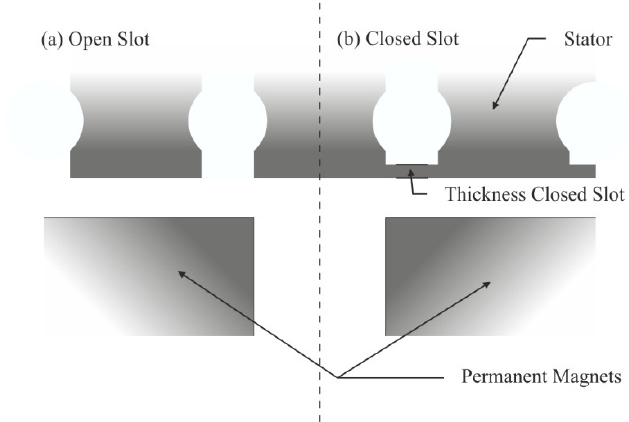
Figure 2. One section of the linear generator showing the difference between: ( a ) open slot; and ( b ) closed